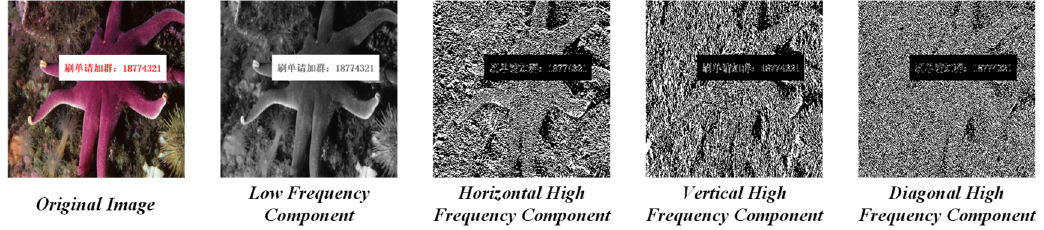
Figure 3. The corresponding frequency domain images after Haar wavelet decomposition of an image with spam.